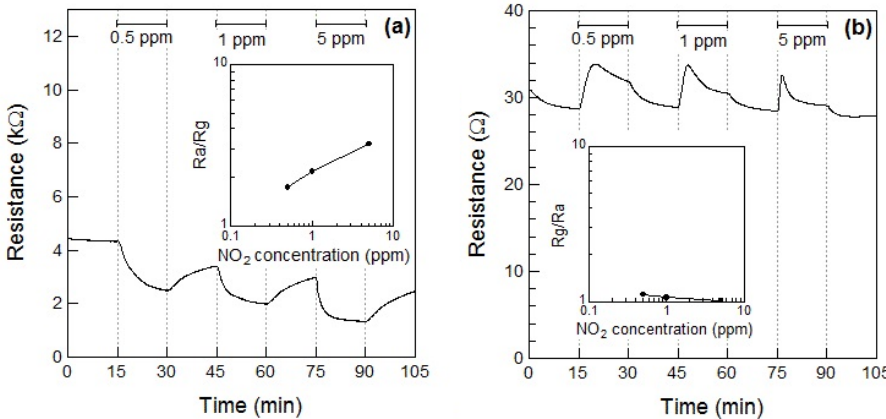
O powder during exposure to NO 3 4 2